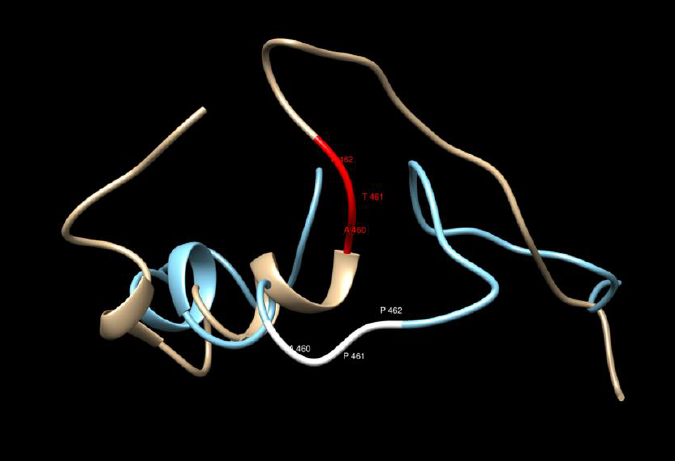
Figure 2. Secondary structure comparison in the region of the T461P replacement.